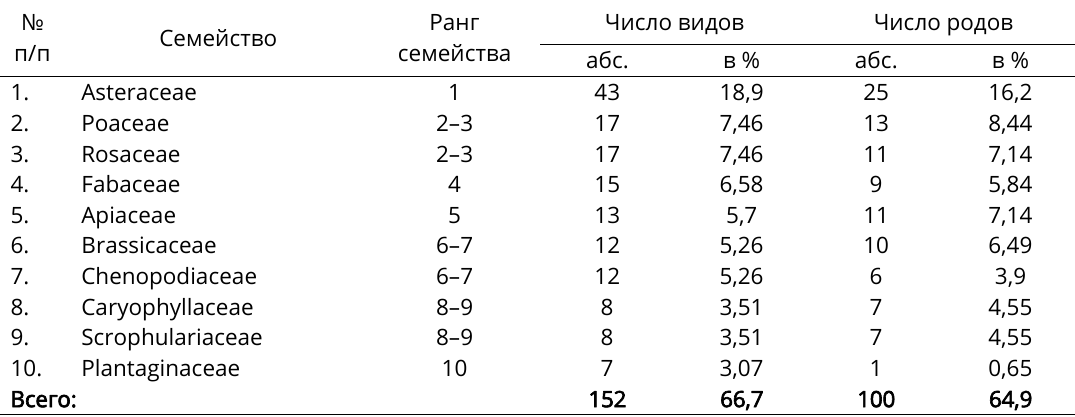
Table 1. The head part of the taxonomic spectrum of the flora of vascular plants of the regional nature